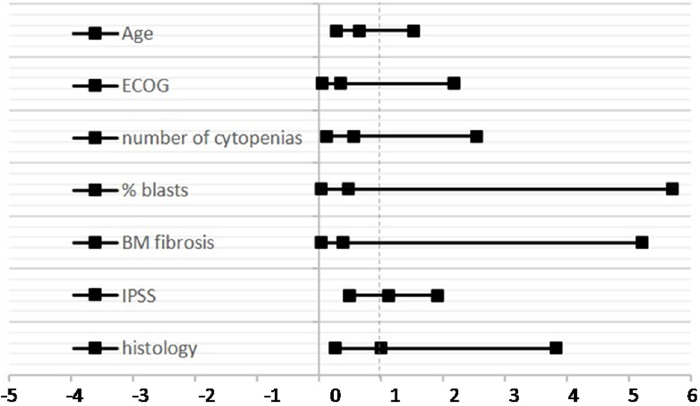
Figure 4. Forest plot indicating the relative risk according to clinical factors and response to ESA. Table 2. Relative risk according to clinical parameters and response to ESA.